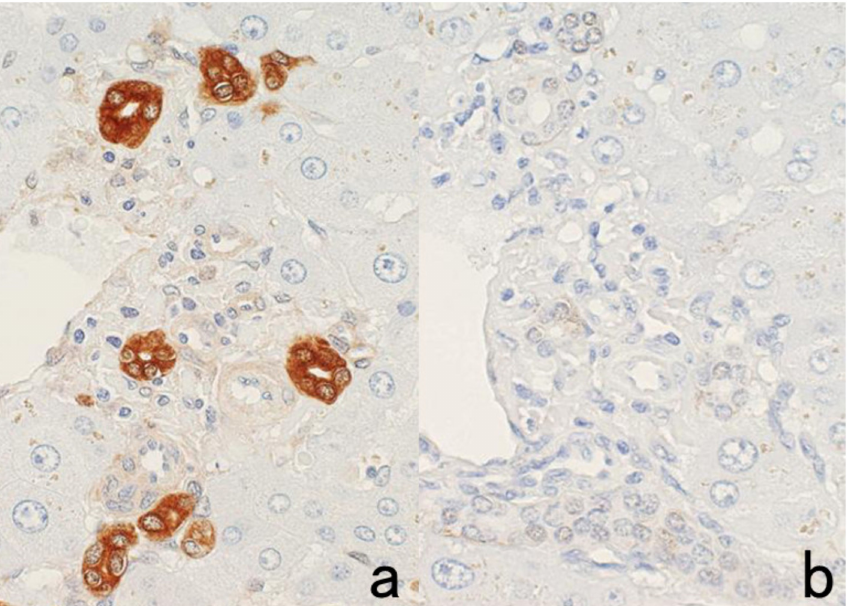
Figure 25. Antigenic loss by stretching sections on a hot plate. Immunostaining for glutathione-S- transferase (GST)- π in the normal liver after stretching on a hot plate at 50 ◦ C for 10 s ( a ) and at 70 ◦ C for 3 s ( b ). The cytoplasmic immunoreactivity of GST- π in the bile duct cells is completely lost by high-temperature stretching at 70 ◦ C for even a very short period.